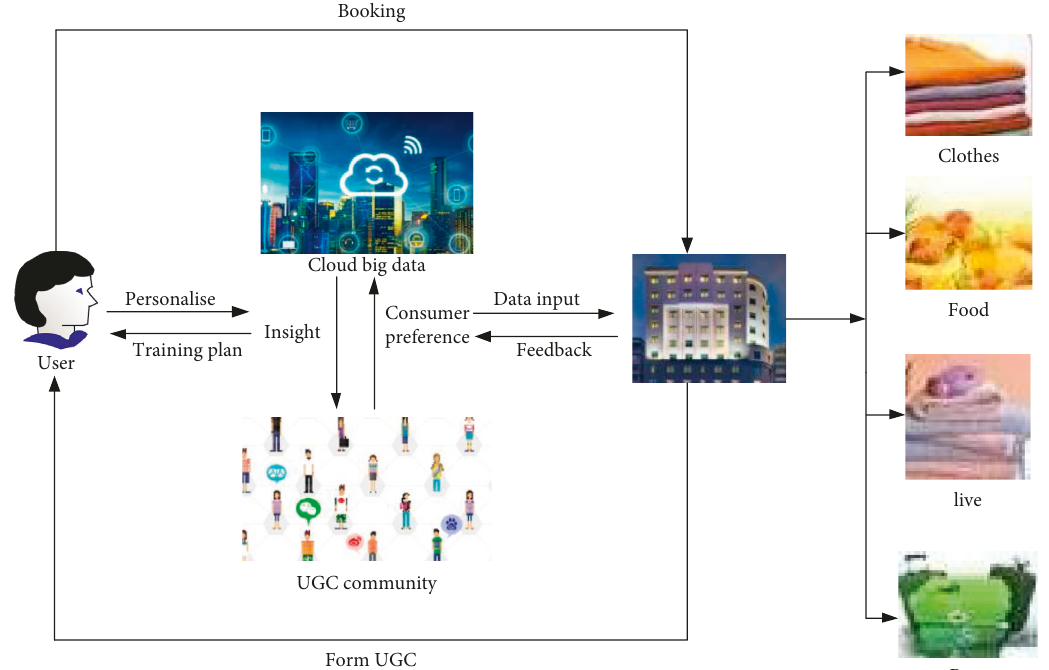
Figure 1: The specific process of UGC community image